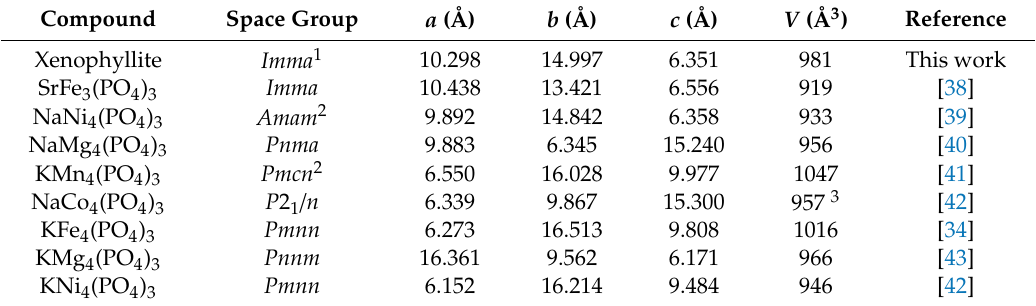
Table 7. Comparison of I -centered subcell of xenophyllite with the unit cells of galileiite-like synthetic